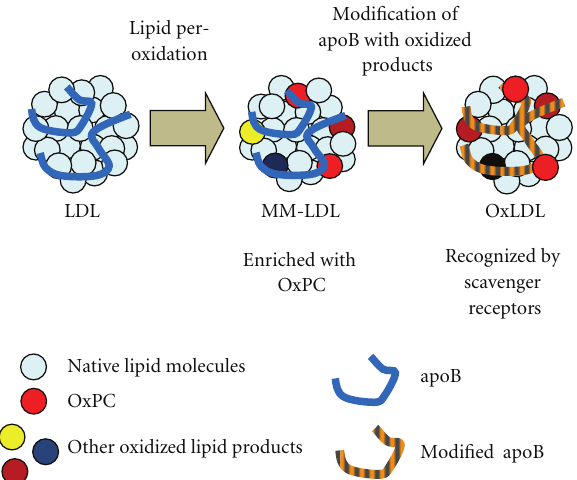
Figure 3: Di ff erence between OxLDL and MM-LDL. LDL is thought to be modified in a stepwise manner during the generation of OxLDL. In the initial phase of modification, the lipid compo- nents (sky blue circle) react with oxidation reagents, resulting in radical chain reactions that produce many types of lipid oxidation products (red, brown, yellow, or dark blue circle). Then, the lipid oxidation products react with the apoB protein (blue line) to generate adducts and cross-links. Radicals can attack the apoB protein directly, resulting in oxidative changes of amino acid side chains and the cleavage of peptide bonds (orange-grey line). MM-LDL may contain lipid oxidation products without extensive protein modification, because it binds to LDL receptor rather than scavenger receptors. As modification on the apoB protein proceeds, its mobility in the agarose gel electrophoresis changes greatly, and it loses the a ffi nity to LDL receptor, and, in turn, it becomes a ligand of scavenger